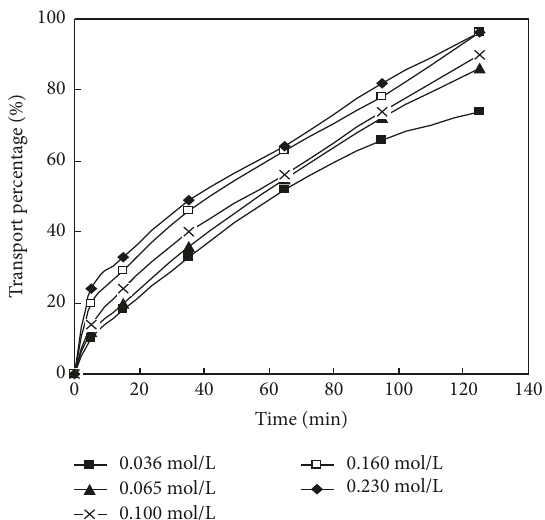
Figure 7: Effect of different carrier concentration on migration of La